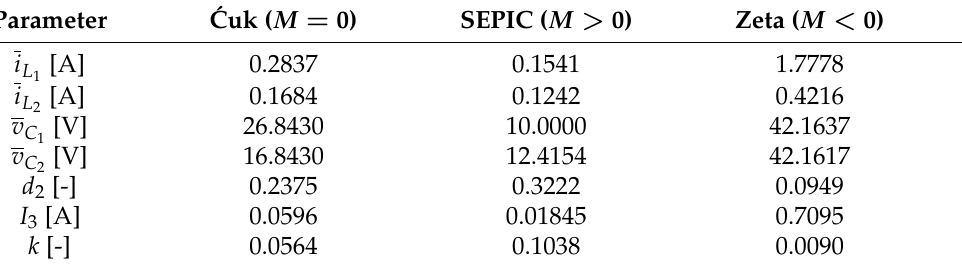
Table 4. Theoretical operation points for the Test-1